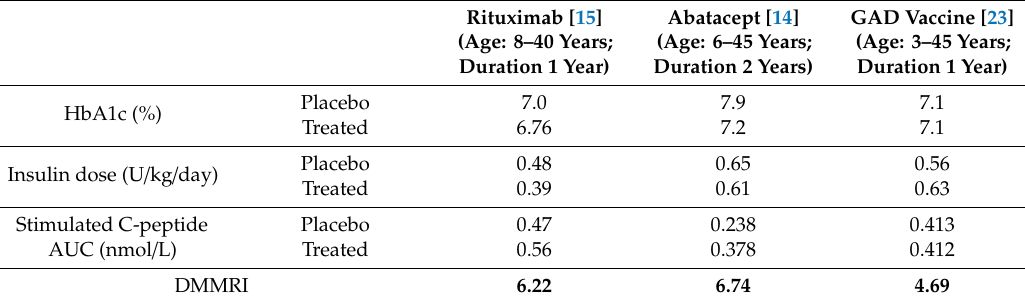
Table 1. Type 1 diabetes mellitus metabolic recovery index (DMMRI) for rituximab [15], abatacept (CTLA4-Ig) [14] and GAD